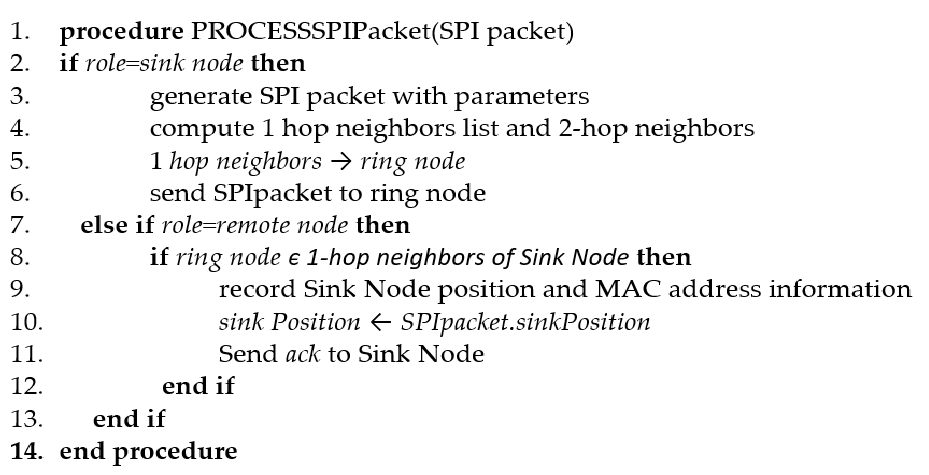
Figure 5. Pseudo code for the procedure of the SPI packets.